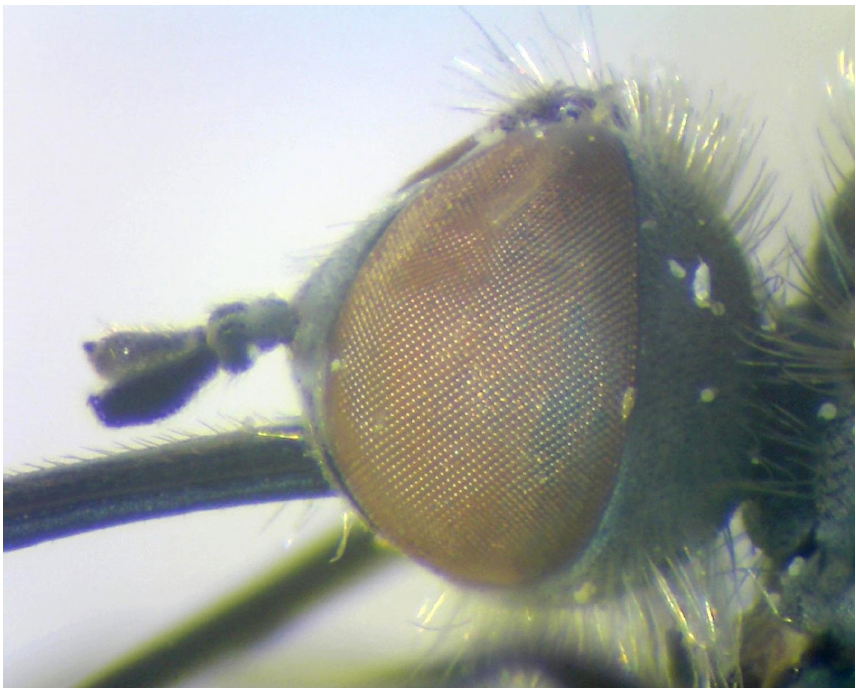
Fig. 17. Parusia loewi (Becker, 1906) gen. et comb. nov., ♂.